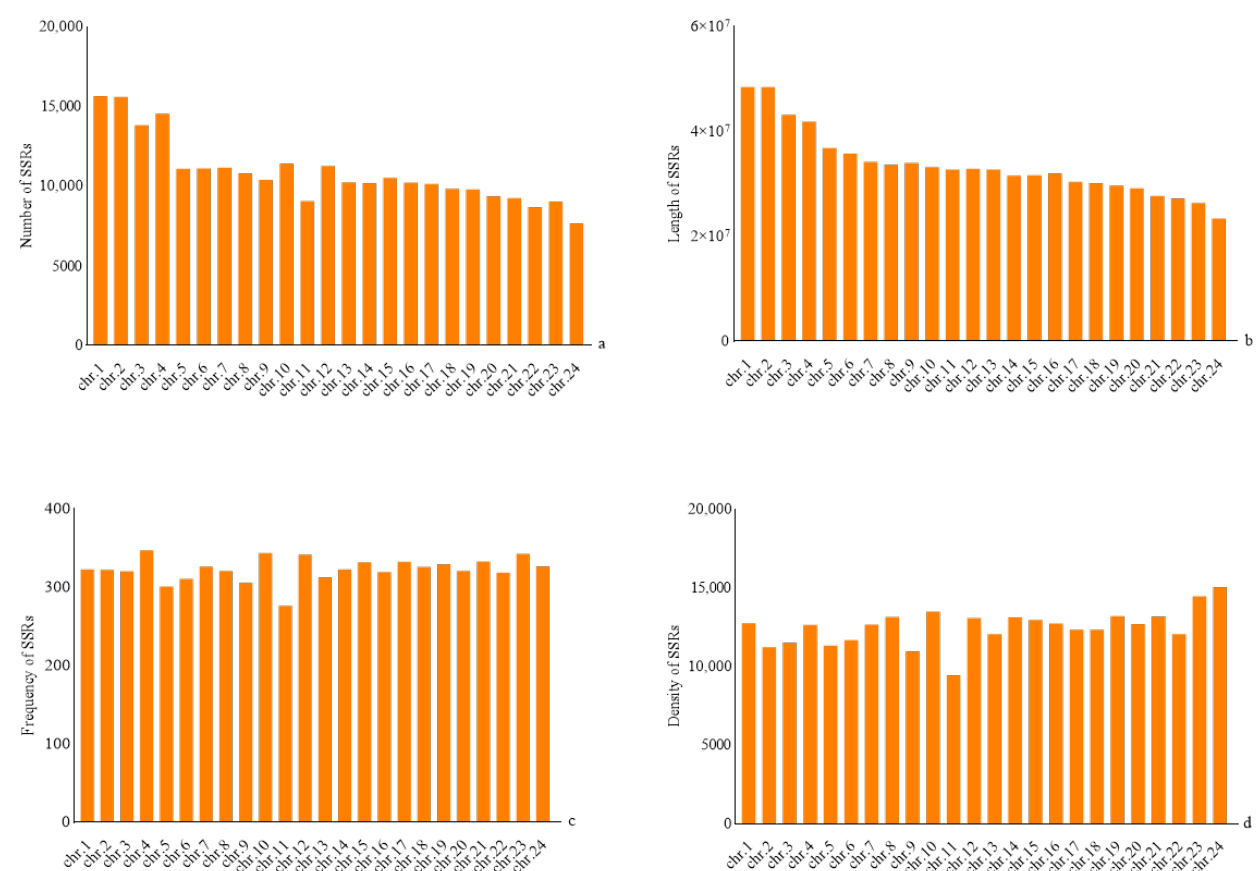
Figure 3. Analysis of SSR frequencies on H. molitrix chromosomes: ( a ) number of SSRs, ( b ) length of SSRs, ( c ) frequency of SSRs, and ( d ) density of SSRs.